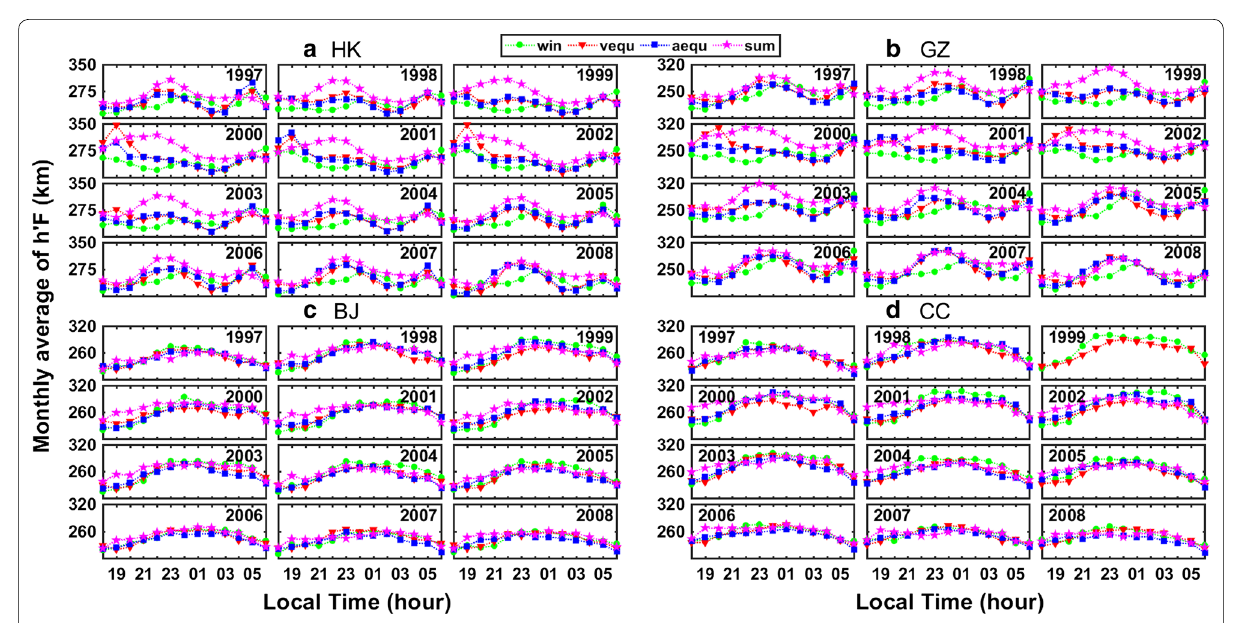
Fig. 11 Seasonal variation of the monthly medians of the h ′ F at HK ( a ), GZ ( b ), BJ ( c ), and CC ( d